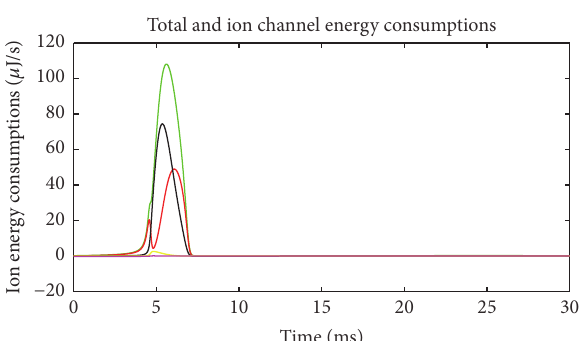
Figure 6: Power ratio of Na + and K + channels (suprathreshold).